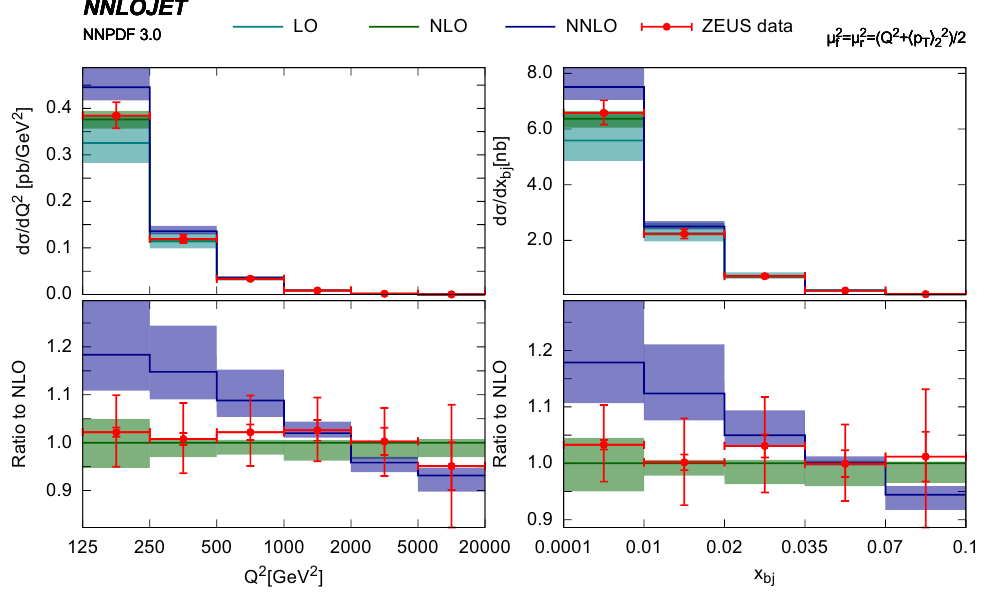
Figure 8 . Inclusive di-jet production cross section as a function of the electron variables Q 2 (left) and x (right), compared to ZEUS